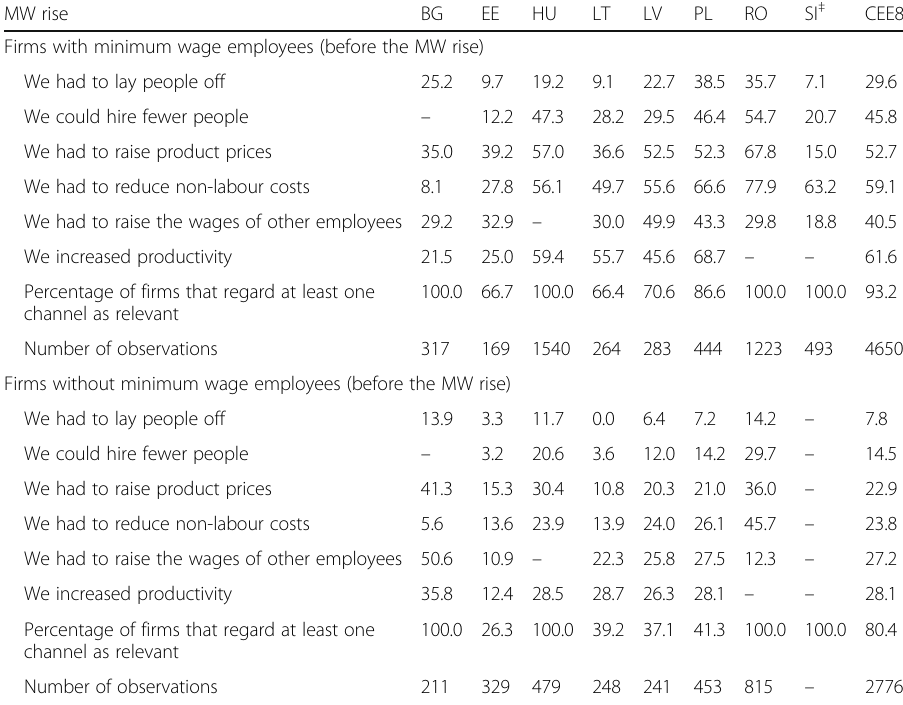
Table 4 Share of firms answering that the minimum wage adjustment channel was ‘ Relevant ’ , in % of the firms in respective sub-group for each country (Relevant + Not Relevant = 100%) MW rise BG